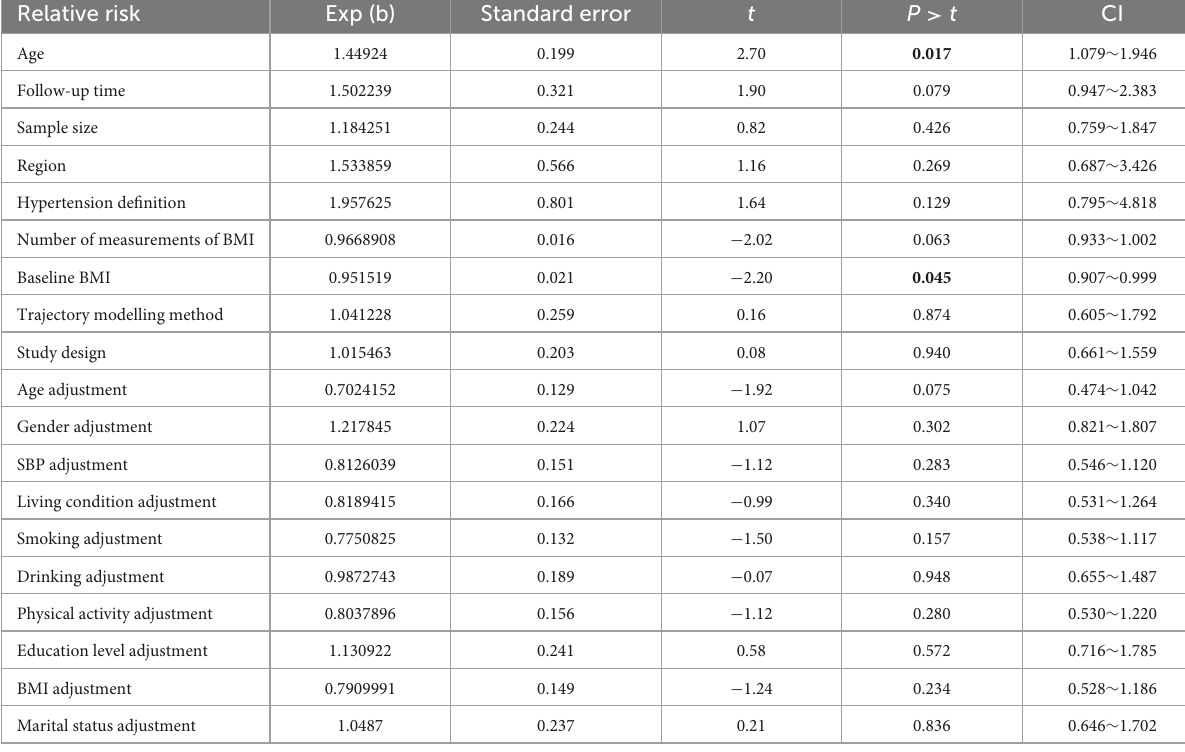
TABLE 4 Results of meta-regression analysis of “Fluctuated (sharp-increase)”